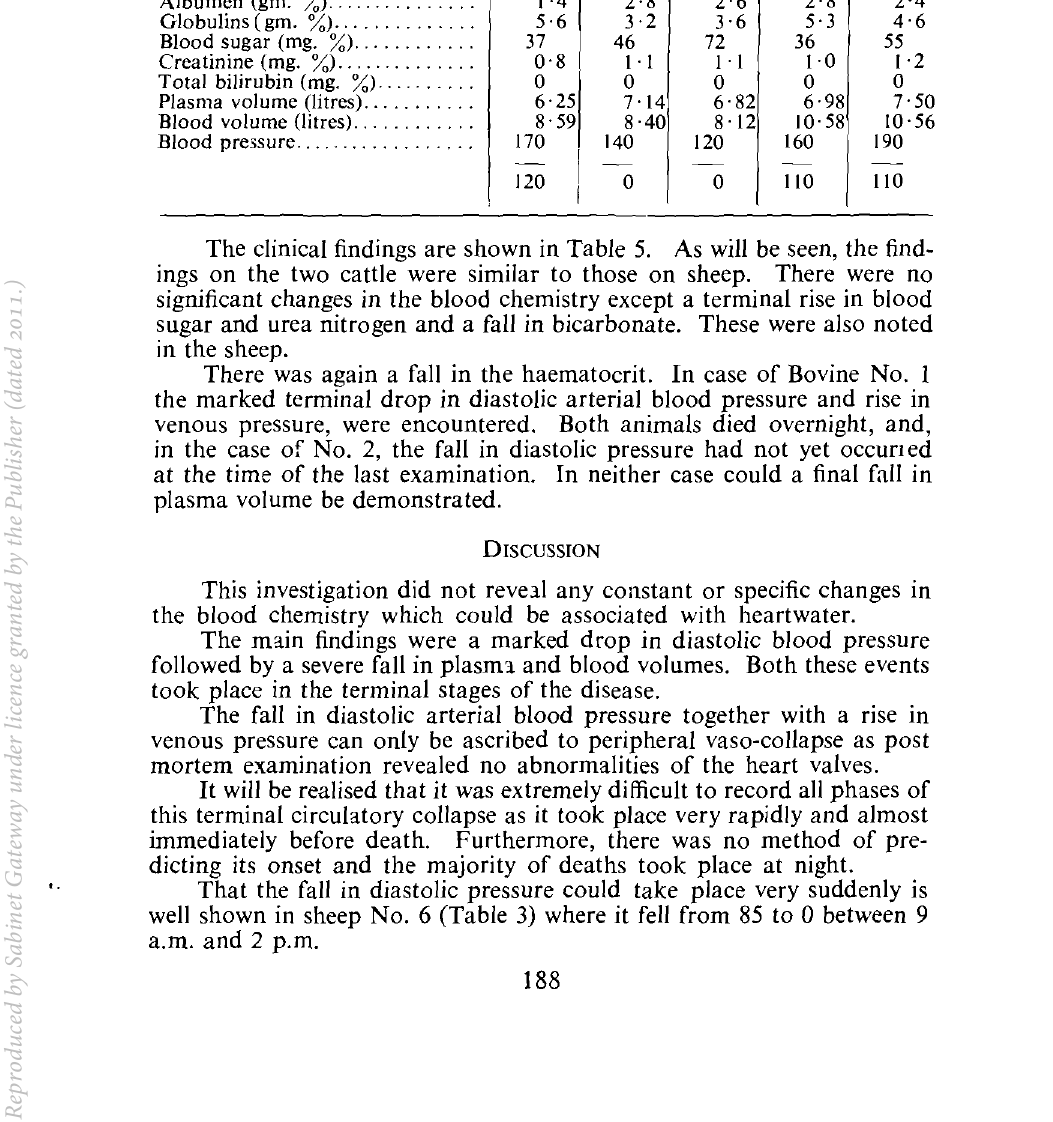
TABLE 5.-Clinicalfindings. Cattle